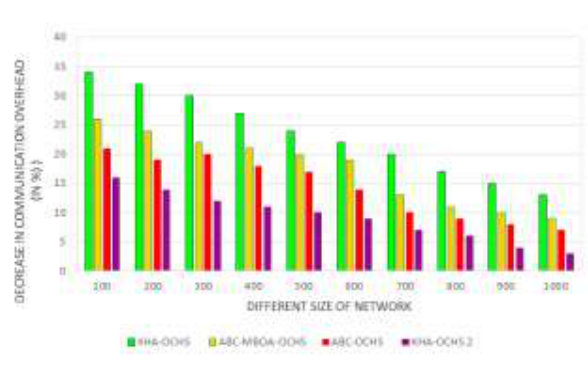
Figure 8 . Proposed NIUS-HEHOA-OCHS: Decrease in communication overhead under